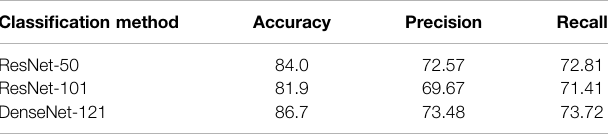
TABLE 3 | Three-class clearness degree baseline classi fi cation results in the CECD dataset.